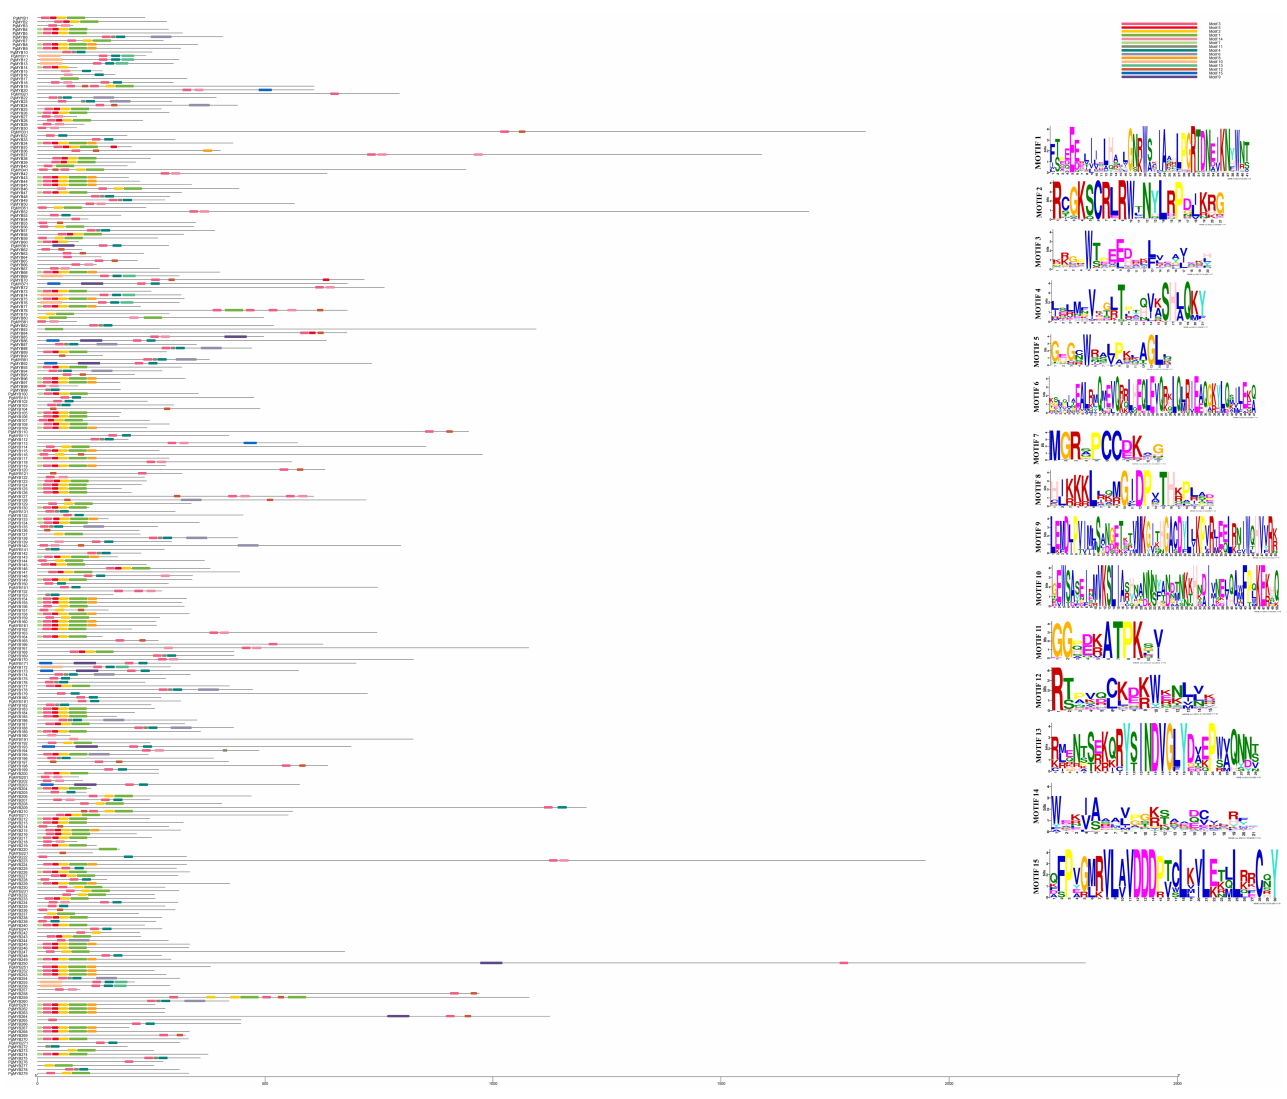
Figure 2. Conserved motif distribution in identified 279 PgMYB proteins. All identified 15 motifs are indicated by different colors and their respective sequence